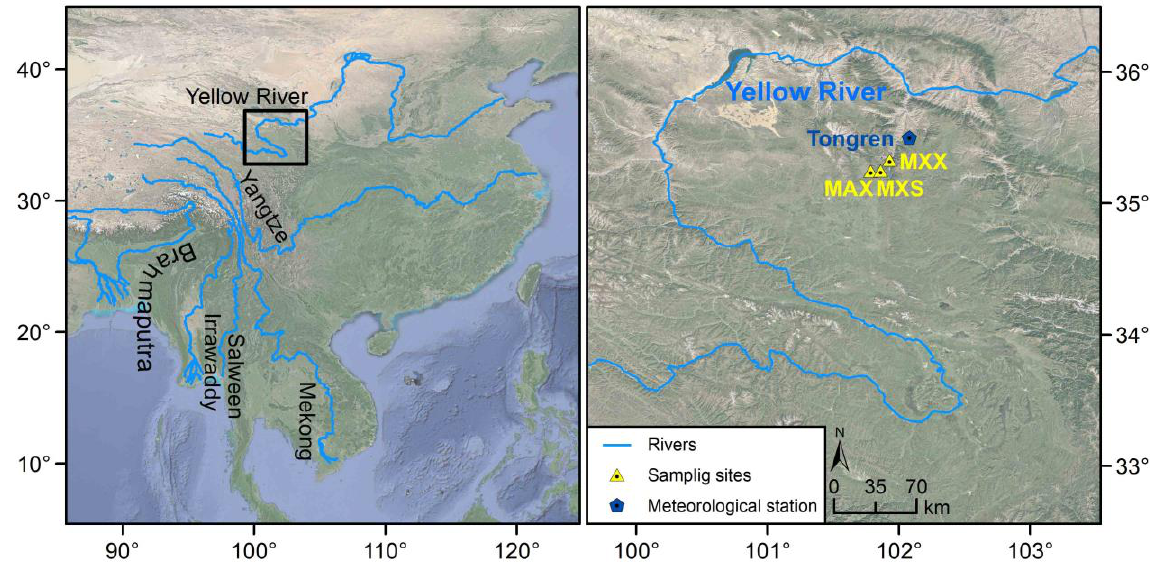
Figure 1. Maps of the sampling sites and the nearest Tongren climate station in the northeastern Tibetan Plateau.